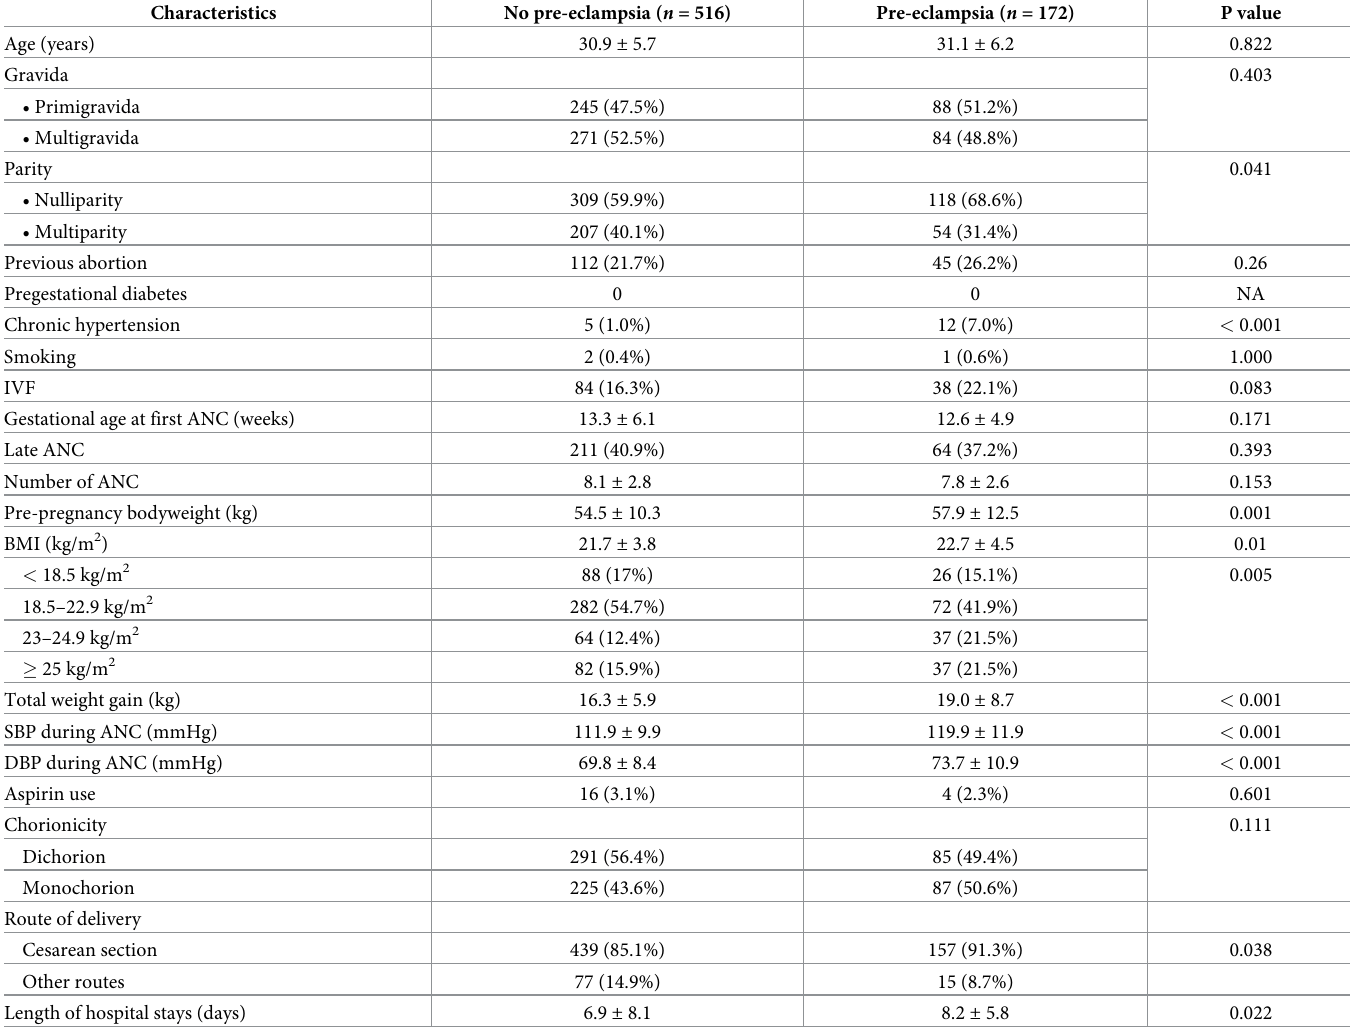
Table 1. Demographic characteristics of the study population.